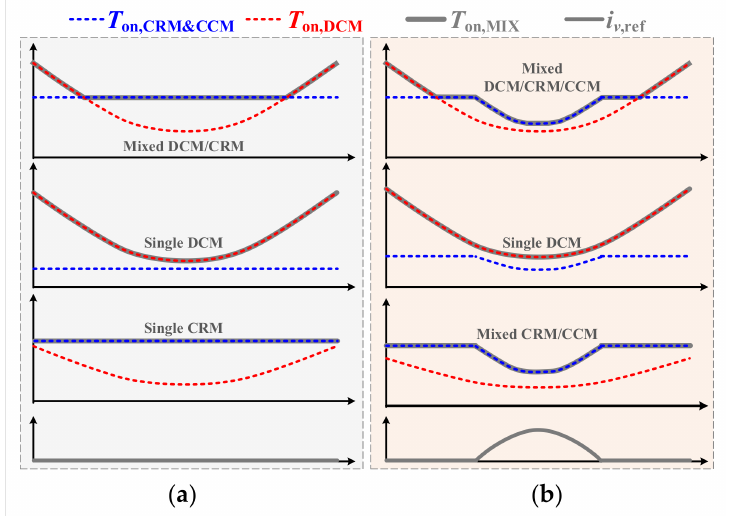
Figure 7. Potential operation modes with different i v ,ref , T on,DCM and T on,CRM&CCM. ( a ) Operations with i v ,ref = 0; ( b ) operations with dynamic changing i v ,ref